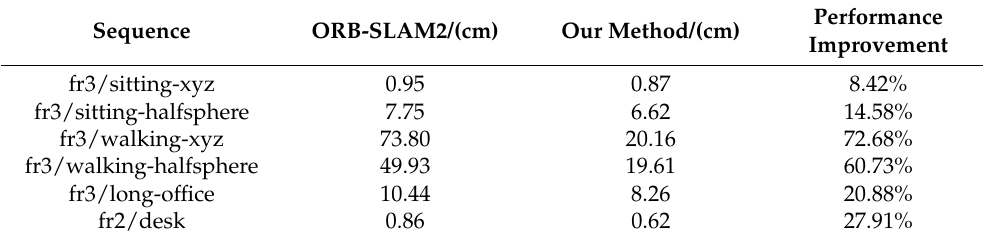
Table 3. Comparison of absolute trajectory